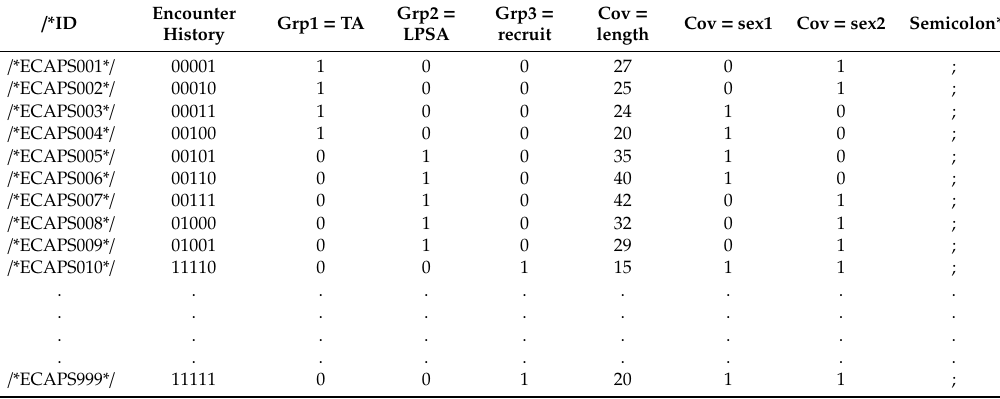
Table A1. An example of a Program MARK input file for Epioblasma capsaeformis closed-population modeling. The first two columns represent the unique mark (tag identification) of an individual and its associated encounter history over five sampling occasions. The next three columns represent the individual’s associated group (TA = translocated adult, LPSA = laboratory-propagated subadult, or recruit; can only be associated with one group), followed by three columns for individual covariates representing mean shell length at capture and sex classification. Sex classification was coded as follows (sex1 = #, sex2 = #): 1,0 = female, 0,1 = male, and 1,1 = sex